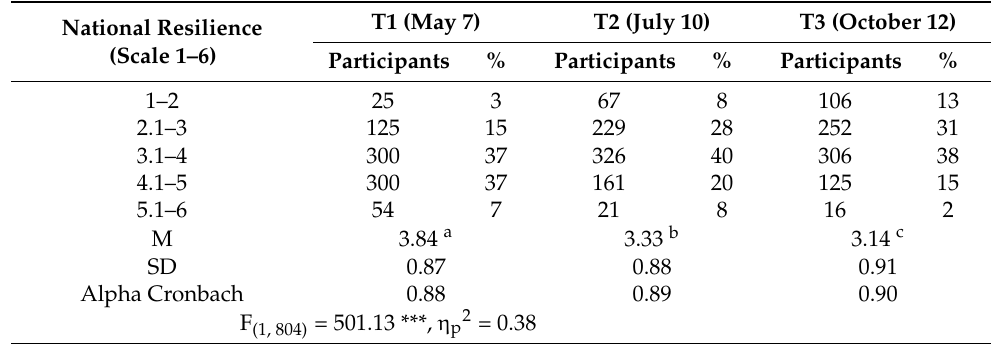
Table 4. Distribution and general linear model—three repeated measurements of the average overall national resilience ( N =